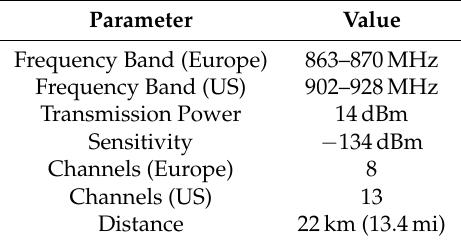
Table 1. SX1272 module